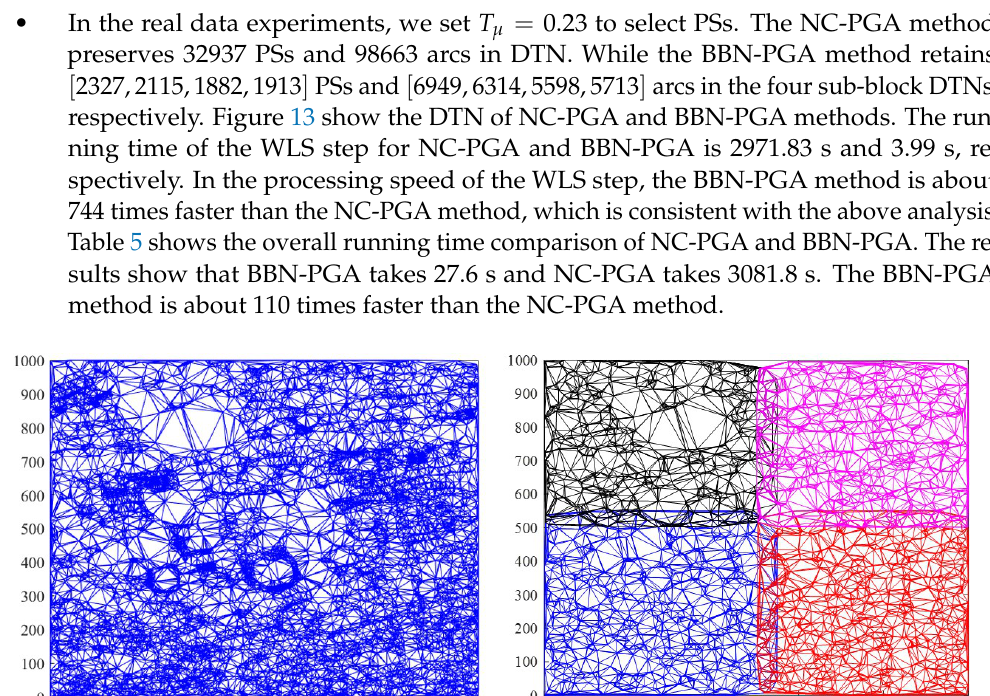
Figure 12. The DTN of the ( a ) NC-PGA and ( b ) BBN-PGA methods in the simulated experiment.